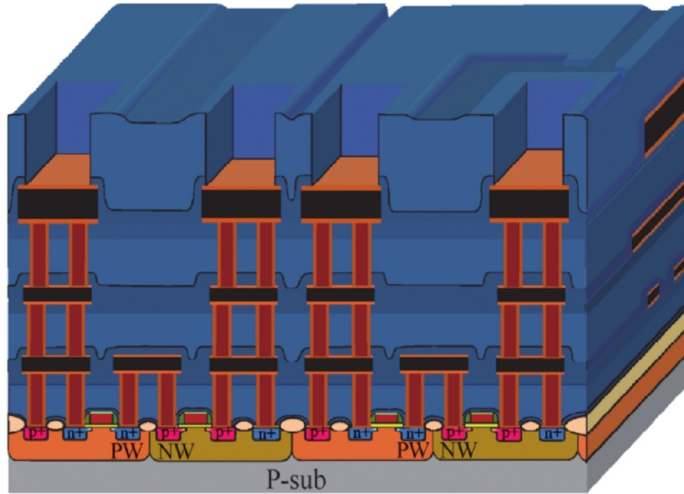
Figure 19. Final wafer profile.